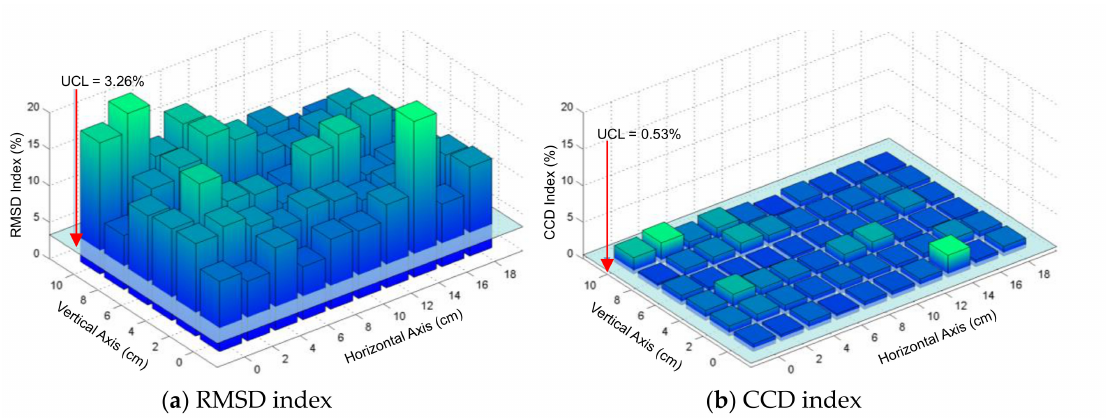
Figure 13. Damage detectability of PZT interface over a quarter of connection splice plate: 30–40 kHz.